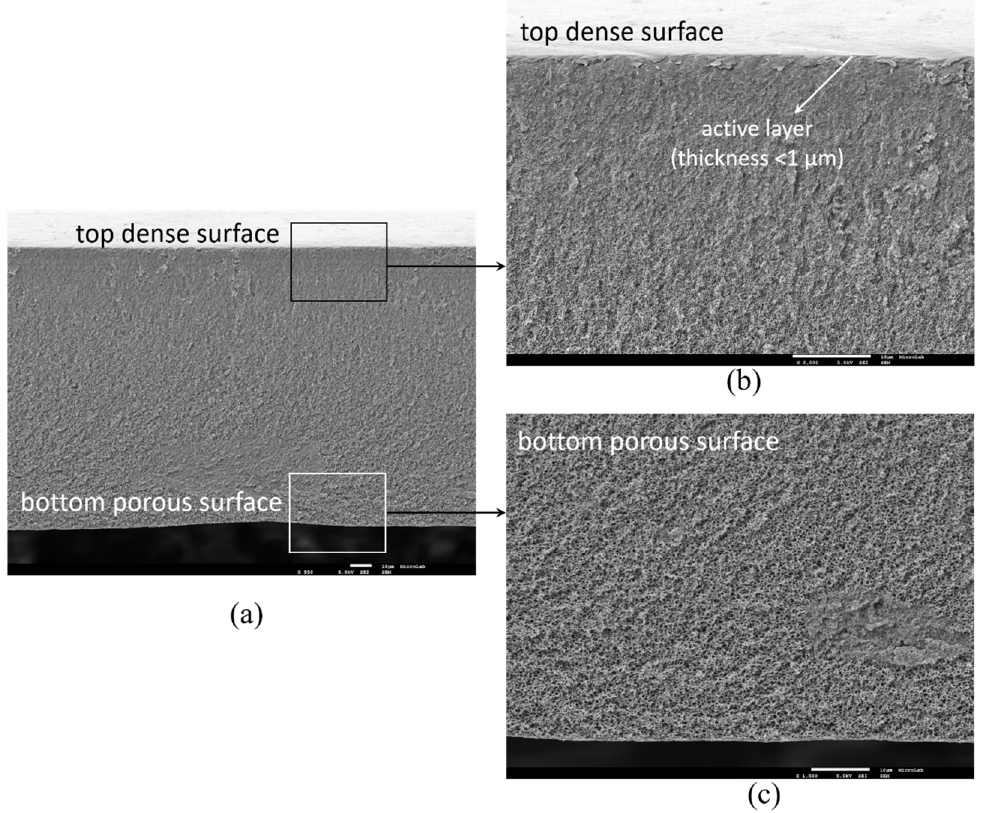
Figure A10. FEG-SEM images of the cross section structure of the CA/SiO 2 /TiO 2 (95:4:1) membranes: ( a ) image of the total cross section structure (550×), ( b ) image of a region near the top dense surface where the active layer thickness can be seen (2000×), and ( c ) image of a region near the bottom porous surface (1500×). Table A3. Ti concentration ([Ti]) (mg/L) of the initial H 2 Od sample and of the final H 2 Od samples collected from the permeate and concentrate cells in the permeation assay. CA/SiO 2 /TiO 2 (95/2/3) and CA/TiO 2 (95/5) membranes were tested.